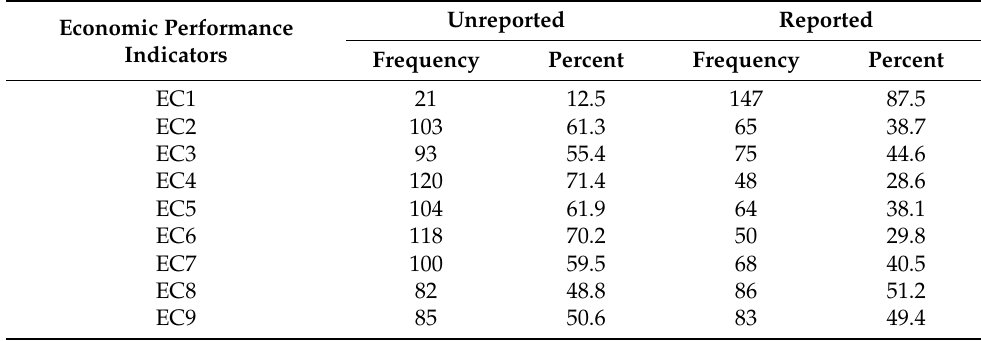
Table 4. Economic performance indicator disclosures.